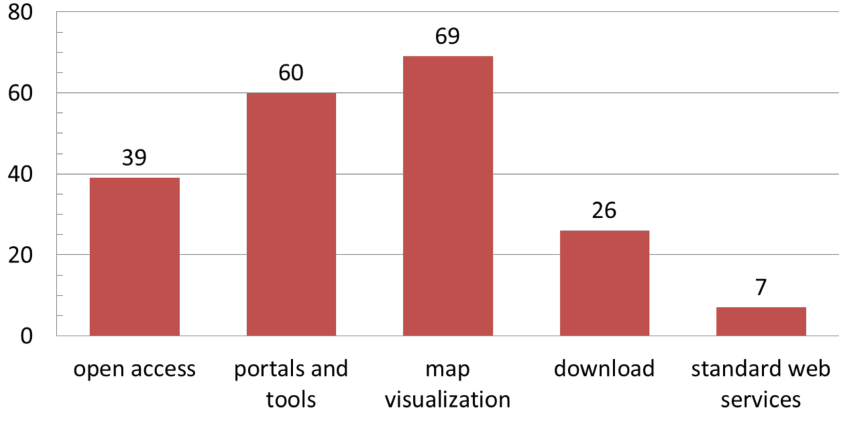
Figure 9. Chart representation of the results relative to the data visualization and access